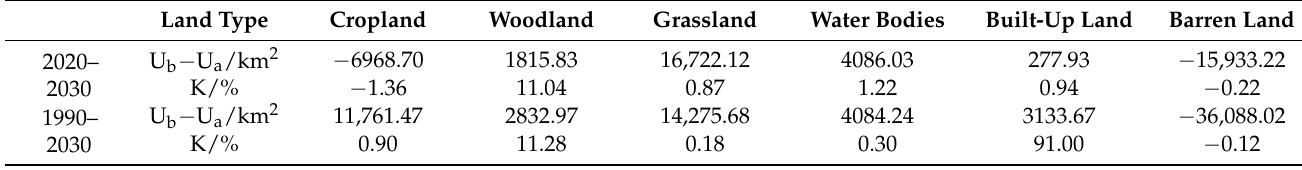
Table 4. Land use dynamic attitude in the Tarim River Basin, 1990–2020